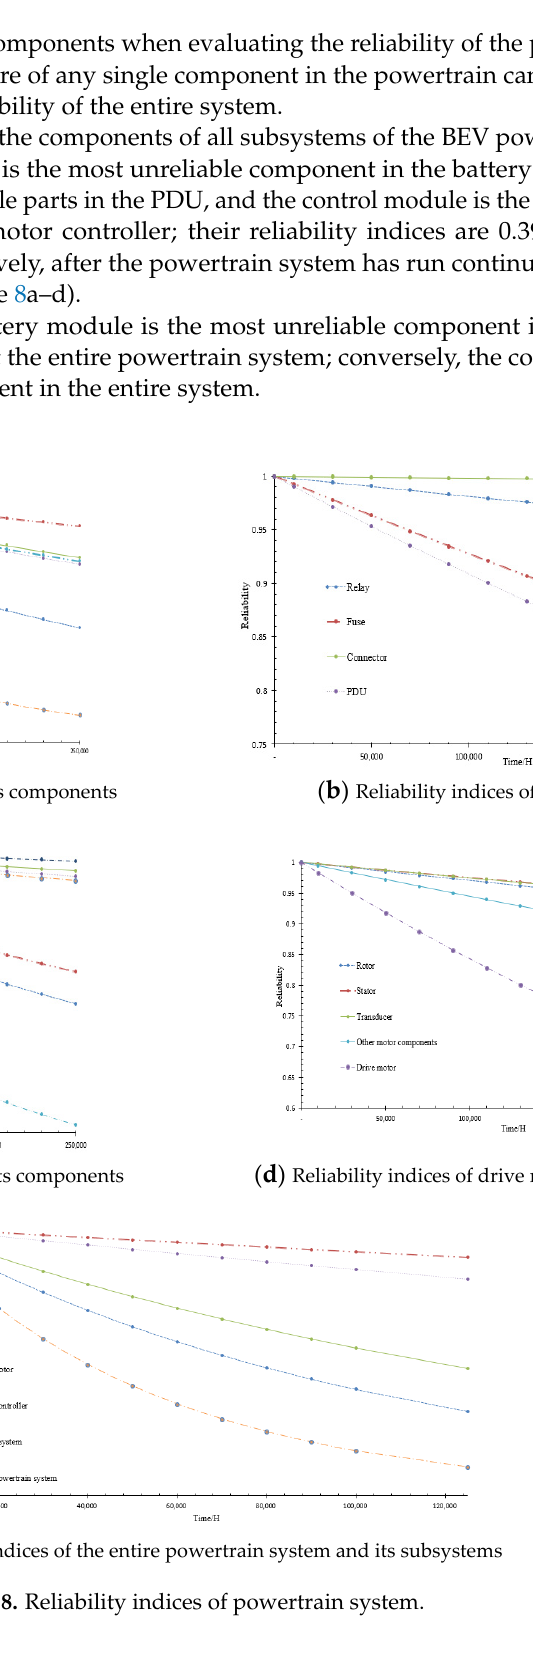
Table 4. Failure rates of powertrain system and its sub-systems.